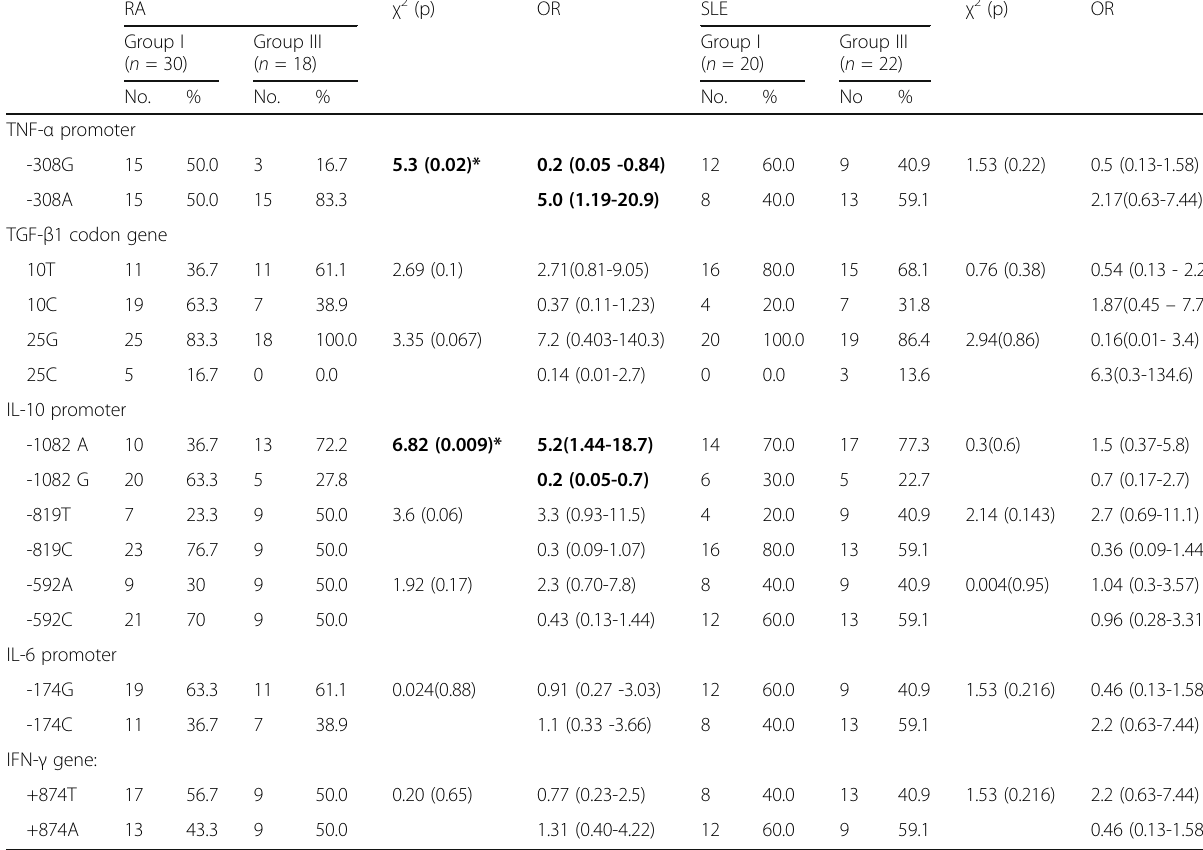
Table 4 Distribution frequency of cytokine genes polymorphisms alleles among RA/SLE patients in group I and III